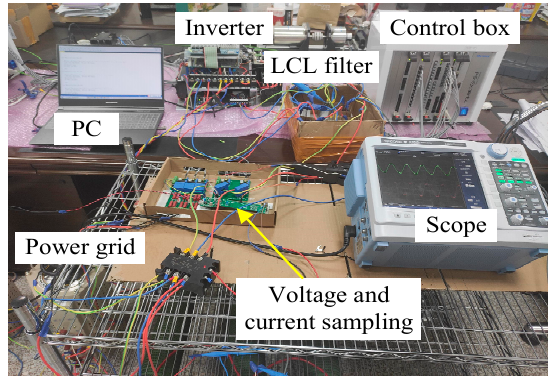
Figure 18. Experimental platform of three ‐ phase grid ‐ connected inverter.